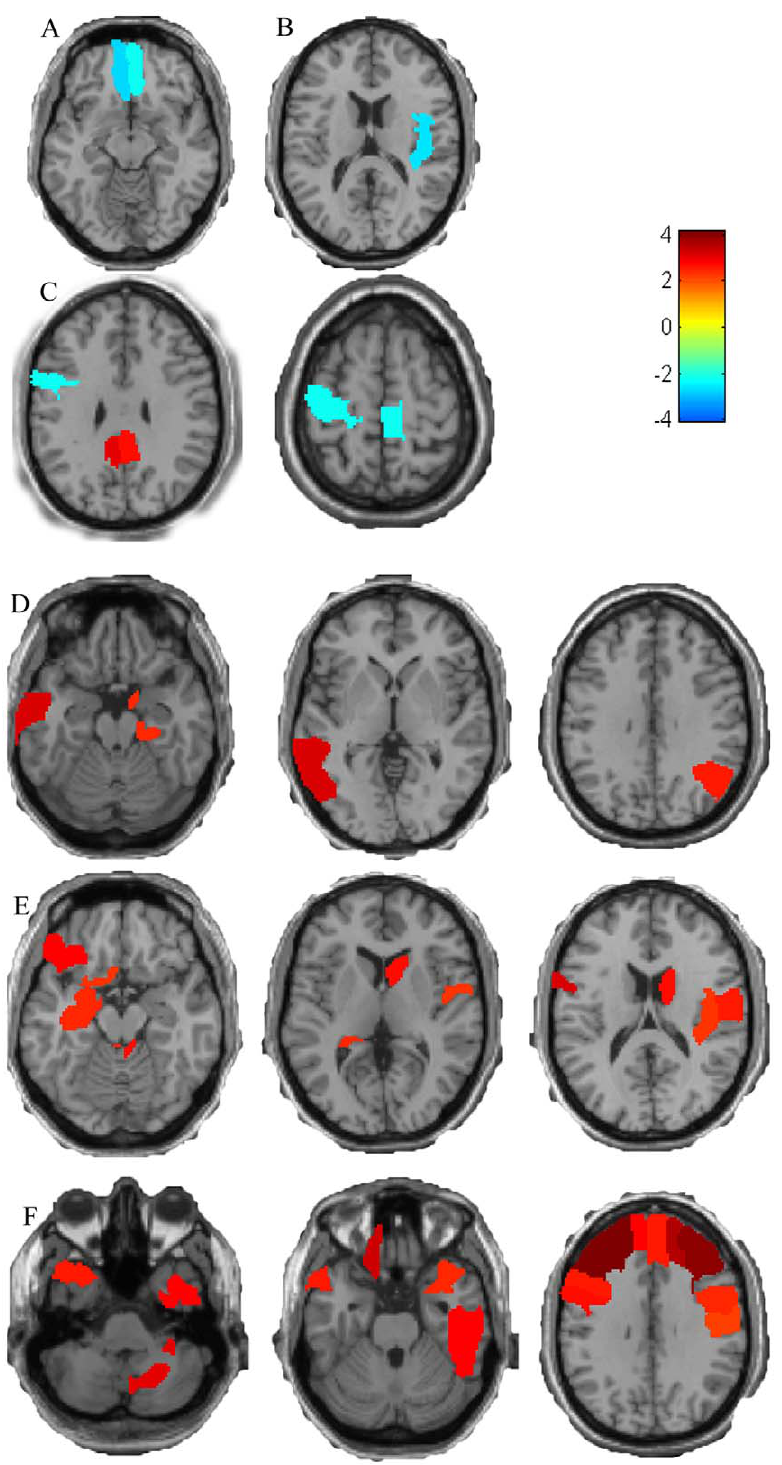
Figure 4. The brain regions which have been selected as features more than 23 times. (A) Selected regions with ReHo. (B) Selected regions with ALFF. (C) Selected regions with GM. (D) Selected regions with RFCS. (E) Selected regions with WM. (F) Selected regions with CSF. doi:10.1371/journal.pone.0047714.g004 proposed method is 0.951, which indicates excellent diagnostic power. Figure 3 is scatter plot of the abnormality index-scores of all subjects.